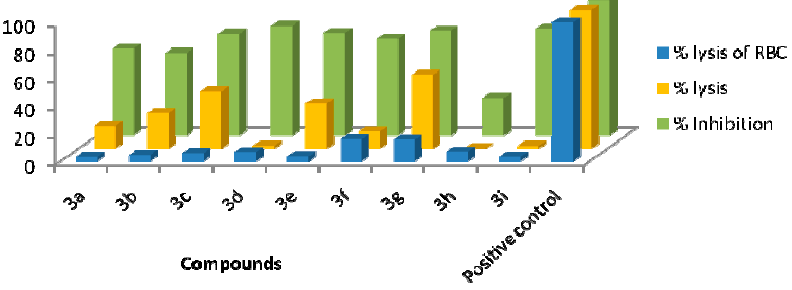
Figure 2. Anti-thrombolytic, biofilm inhibition, and haemolytic activities of 2,5-biaryl-3-hexyl thiophene-based compounds ( 3a – i ). Table 2. The values of % lysis for newly-synthesized 2,5-biaryl-3-hexylthiophene derivatives ( 3a – i ). Entry